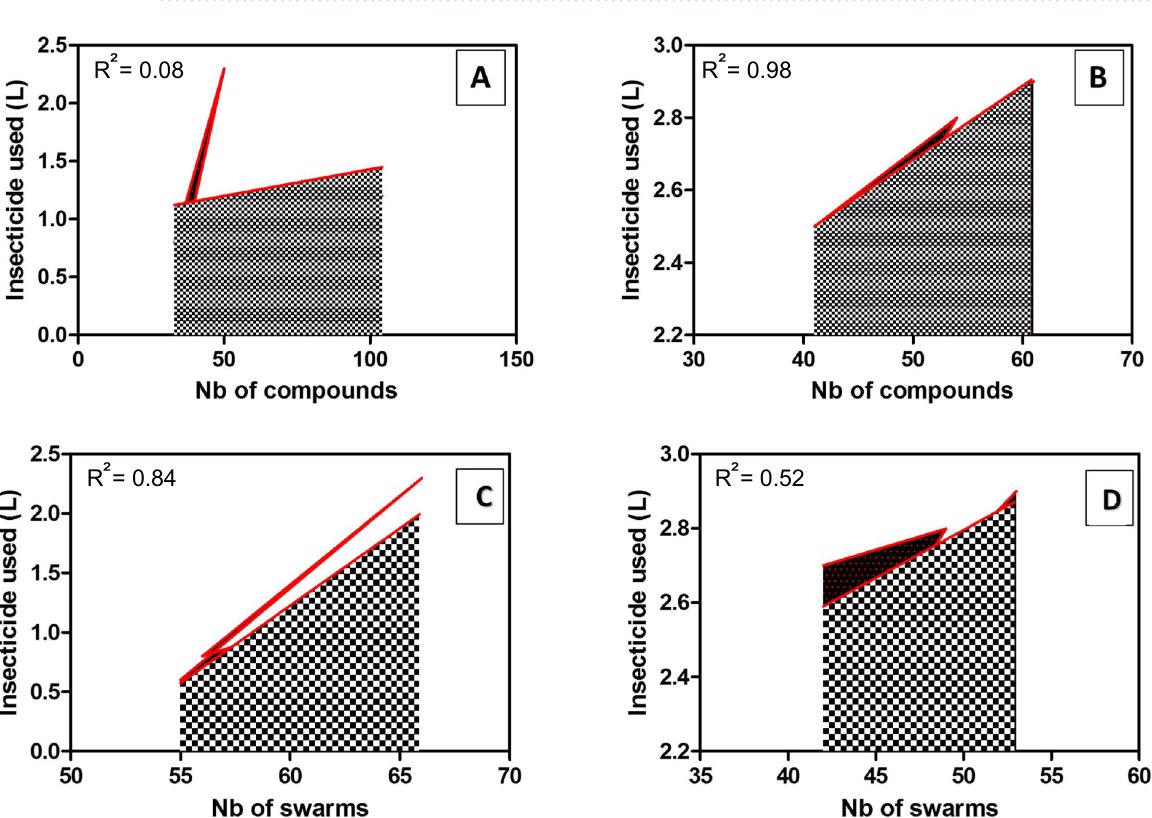
Figure 4. Relationship between number of compounds and the quantity of insecticide used in the targeted spraying ( A ) and Broadcast spraying ( B ). Relationship between the number of swarms and the quantity of insecticide used in the targeted spraying ( C ) and the Broadcast spraying ( D